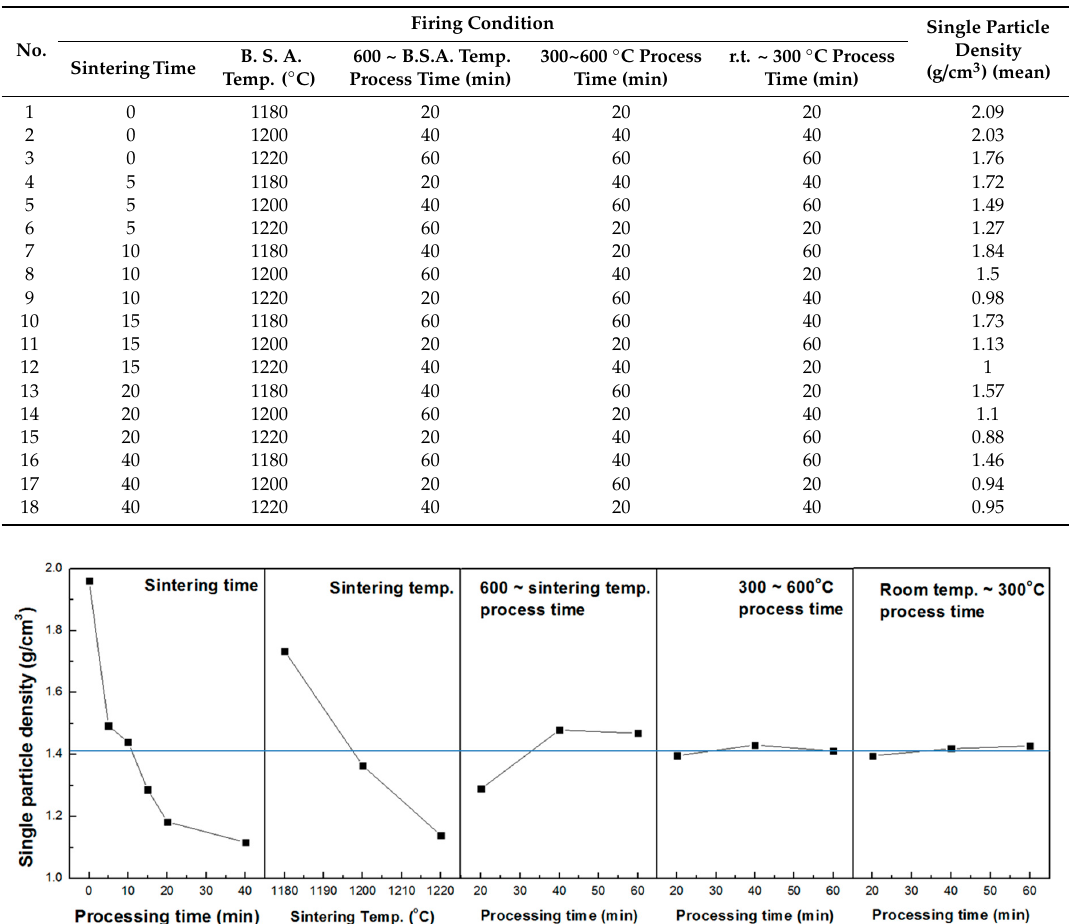
Figure 4. Analysis result of experiment designed with orthogonal array table. According to K õ se et al. [46], the generation and development of pores can be divided into three